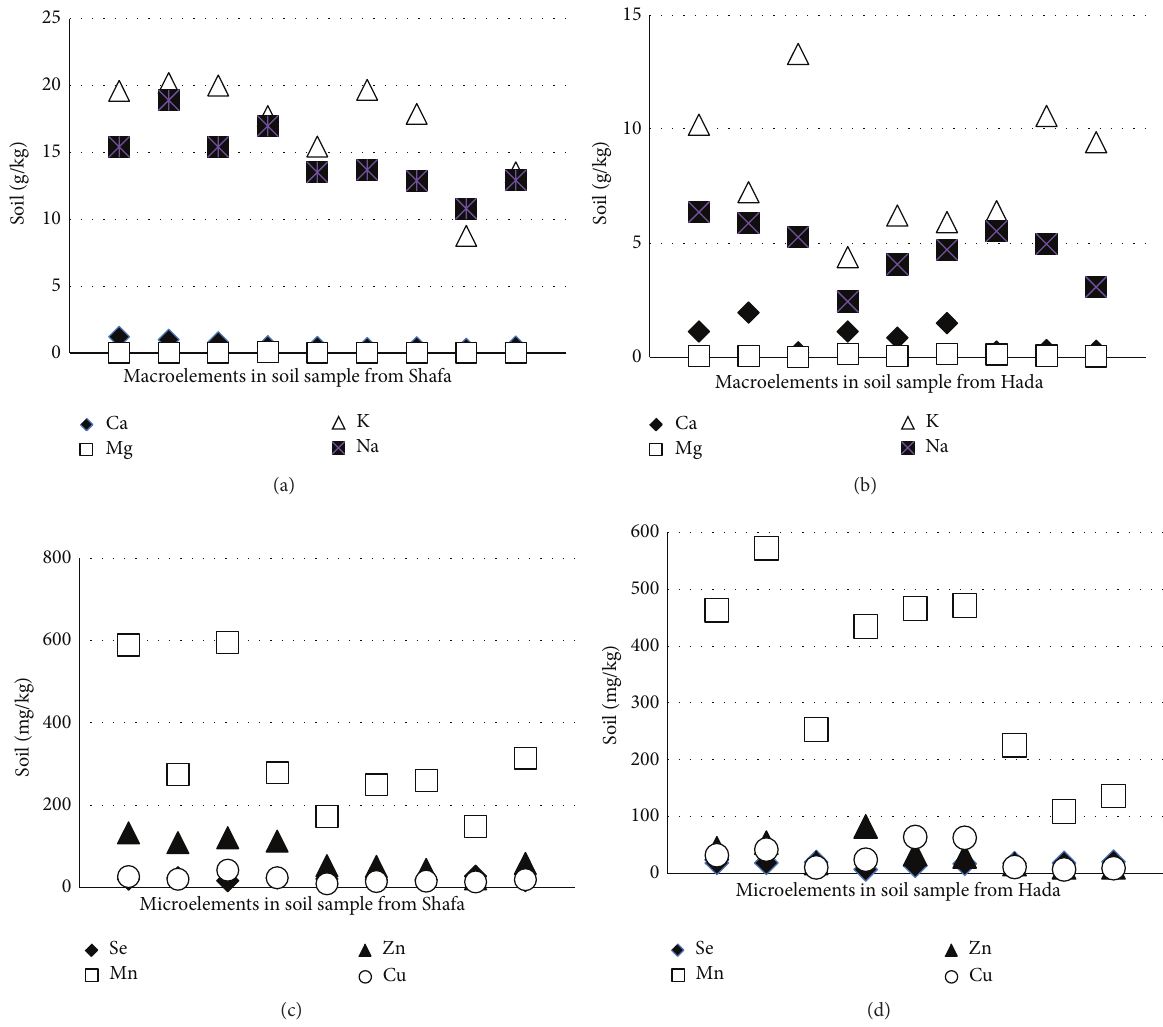
Figure 1: Different levels of macroelements (a and b) and microelements (c and d) in soil samples collected from Shafa and Hada.